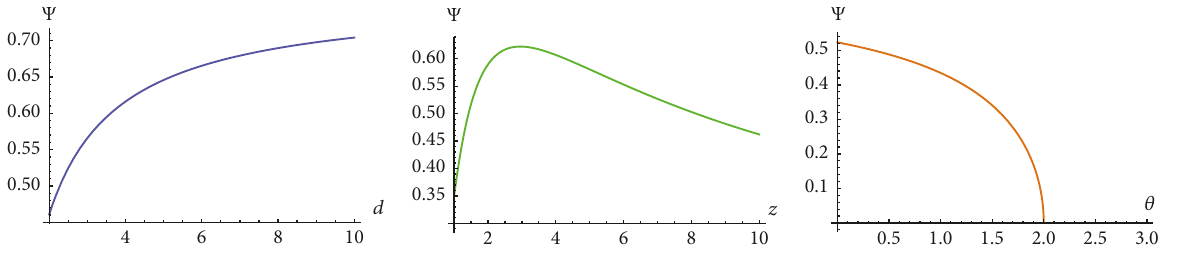
Figure 14: Amplitude Ψ of entanglement entropy as a function of (a) dimension, (b) 𝑧 , and (c) 𝜃 . In (a), we have {𝑧 = 1.5, 𝜃 = 0.1} . In (b), we have {𝑑 = 3, 𝜃 = 0.1} and in (c), {𝑑 = 3,𝑧 = 1.5} . We have set Ω = 1 everywhere.